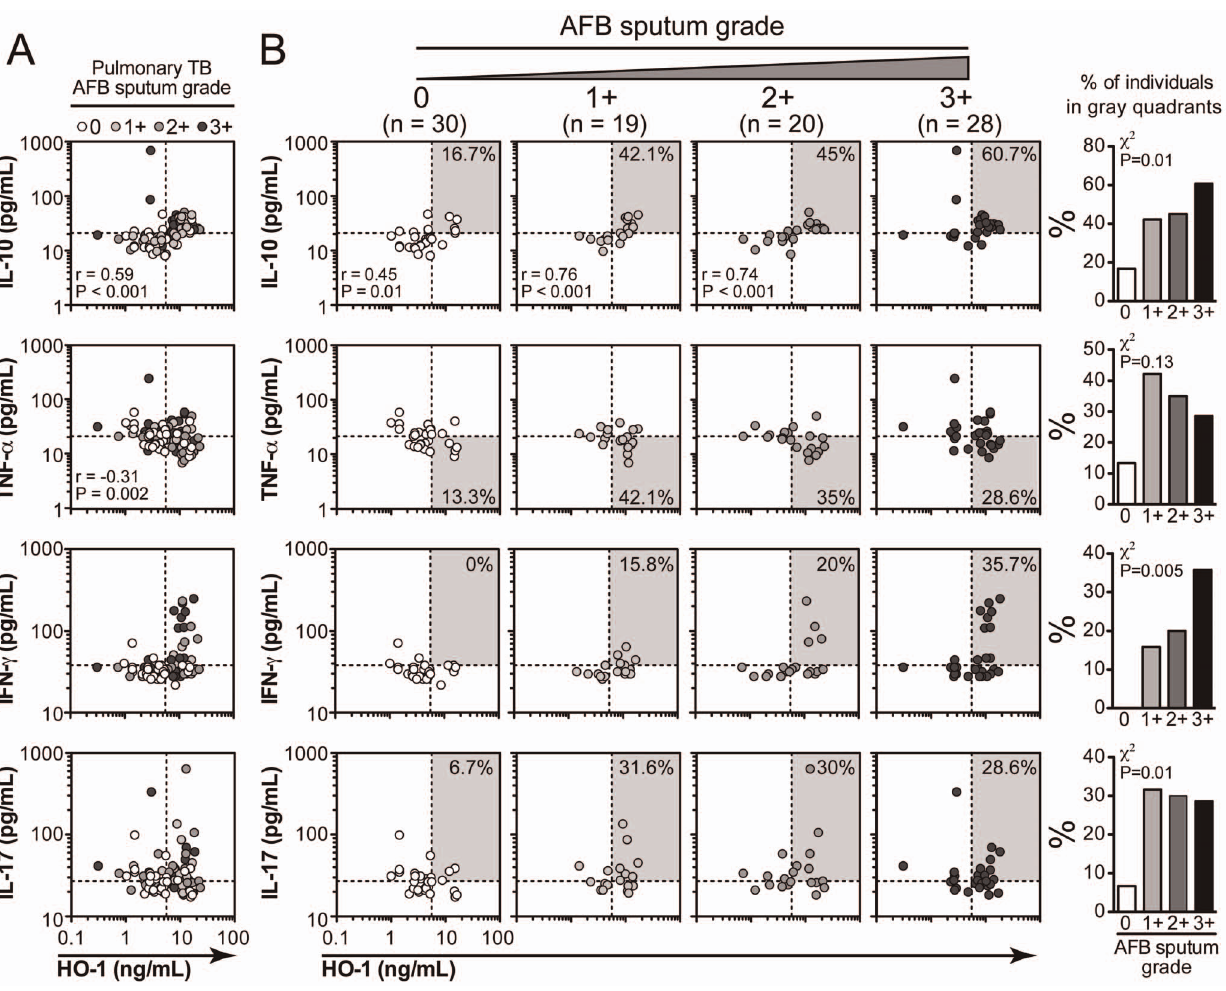
Figure 3. Associations between HO-1 and cytokine levels in active pulmonary tuberculosis. ( A ) Correlations between plasma HO-1 levels and systemic concentrations of IL-10, TNF- a , IFN- c and IL-17 in individuals with active pulmonary tuberculosis (n=97). Dotted lines on the X-axis represent the median value of HO-1 within the group of patients with pulmonary disease, while dotted lines on each Y-axis indicate median values for each cytokine. In ( B ), the correlations were stratified according to the bacillary load in sputum smears. Gray areas designate the quadrants that include the individuals simultaneously displaying values of HO-1 and cytokines above the medians or in the case of TNF- a below the median. Percentage of individuals within in the gray areas was compared between the groups with different bacillary sputum grades using a chi-square analysis and correlations evaluated using Spearman test.